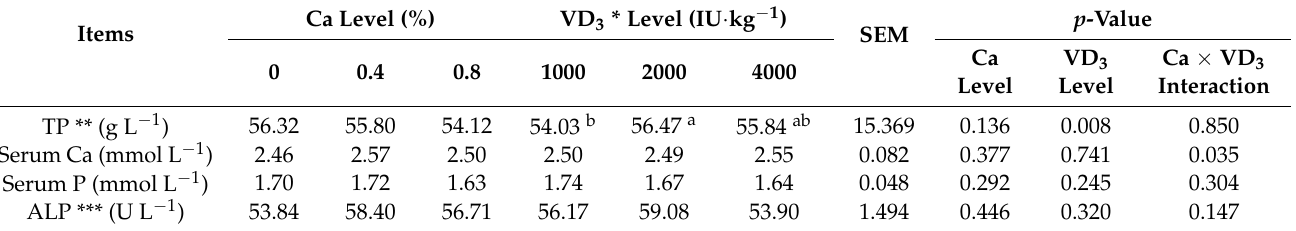
Table 6. The outcome of Ca and VD 3 diet supplementation on serum biochemical indices in maturing and furring blue